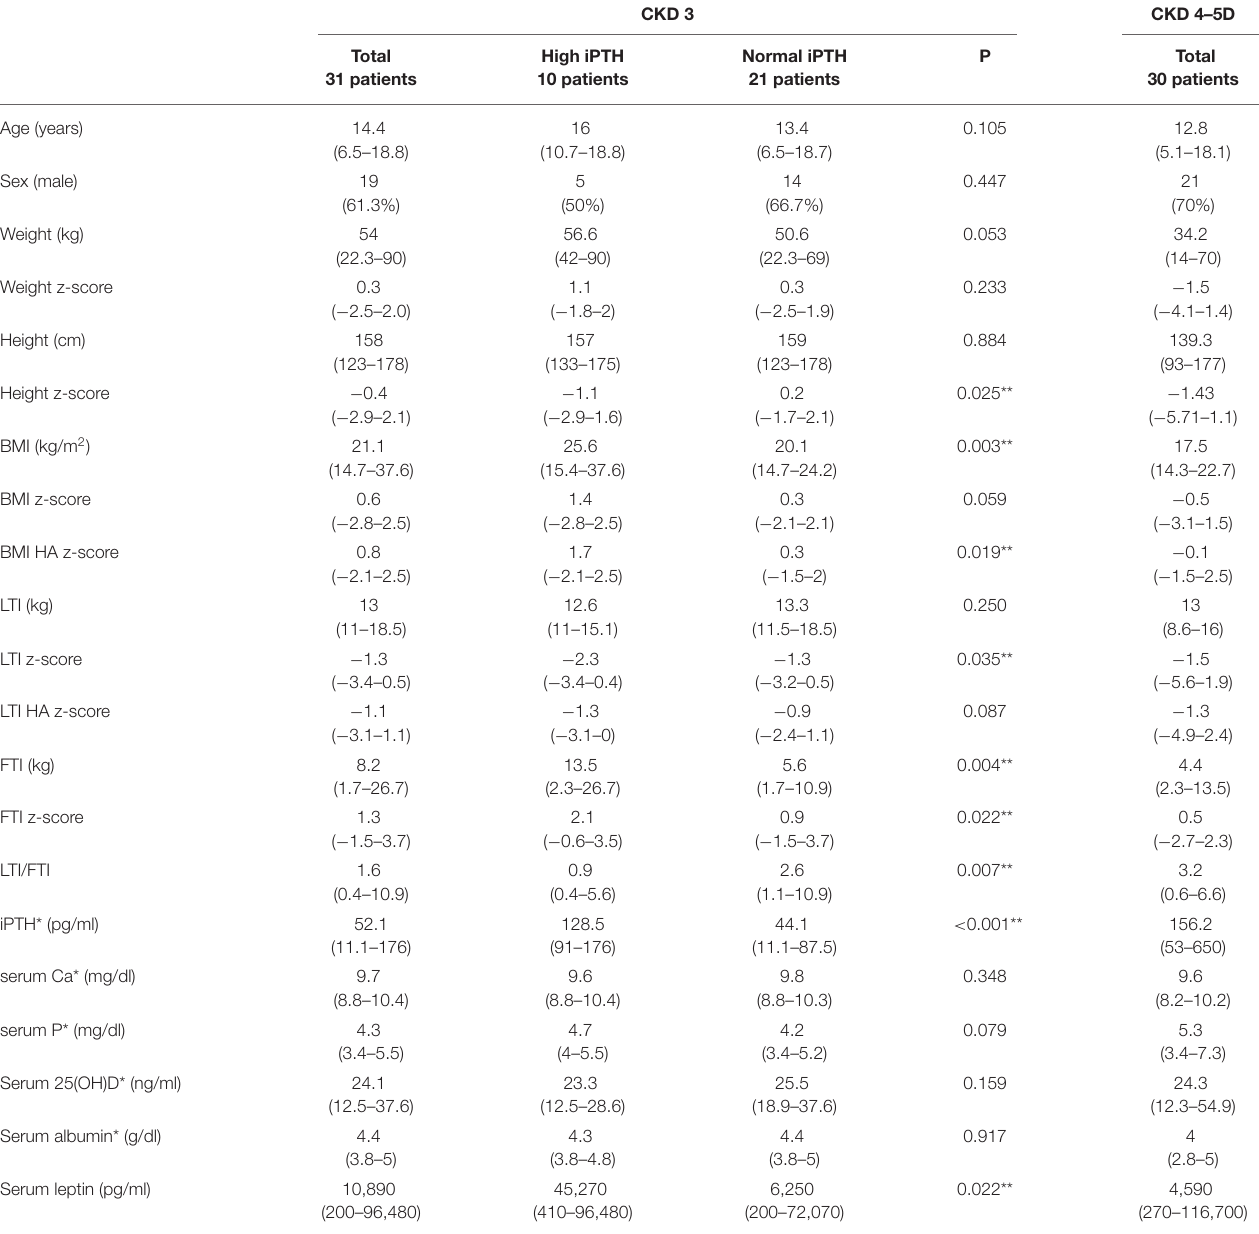
TABLE 1 | Distribution of anthropometric parameters, body composition indices and laboratory data in chronic kidney disease (CKD) stage 3 patients with and without high iPTH ( > 90 ng/ml) and in CKD stage 4-5D